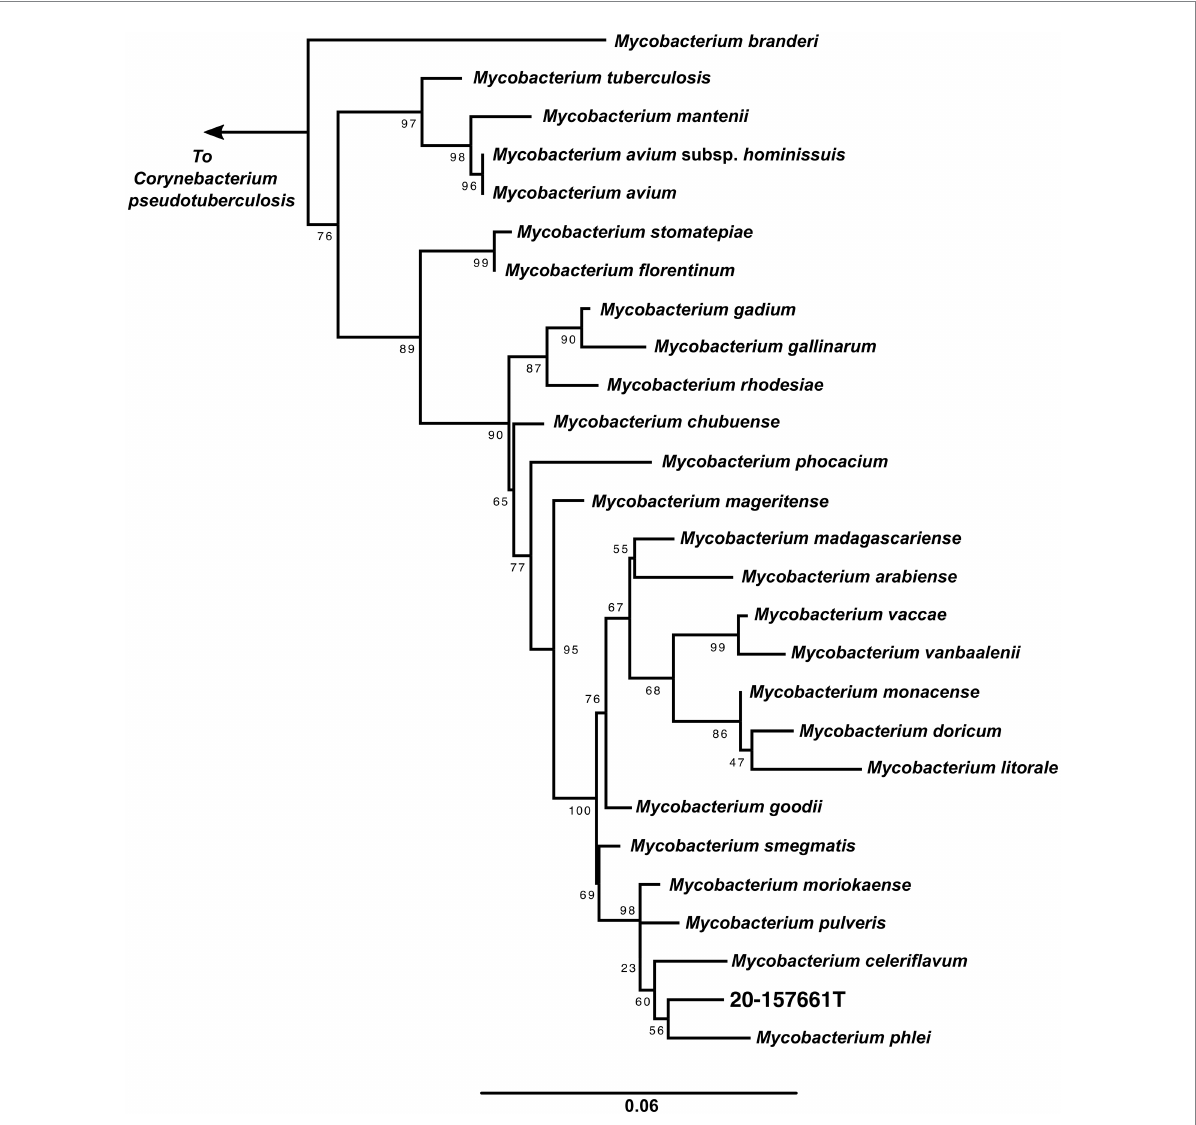
FIGURE 2 16S rRNA maximum likelihood tree. 16S rRNA sequences from the representative genomes in the dataset were aligned using MAFFT (Katoh et al., 2002) and IQ-TREE (Nguyen et al., 2015) was used to calculate the tree with 1,000 bootstraps replicates and using the auto model selection. Corynebacterium pseudotuberculosis was used to root the